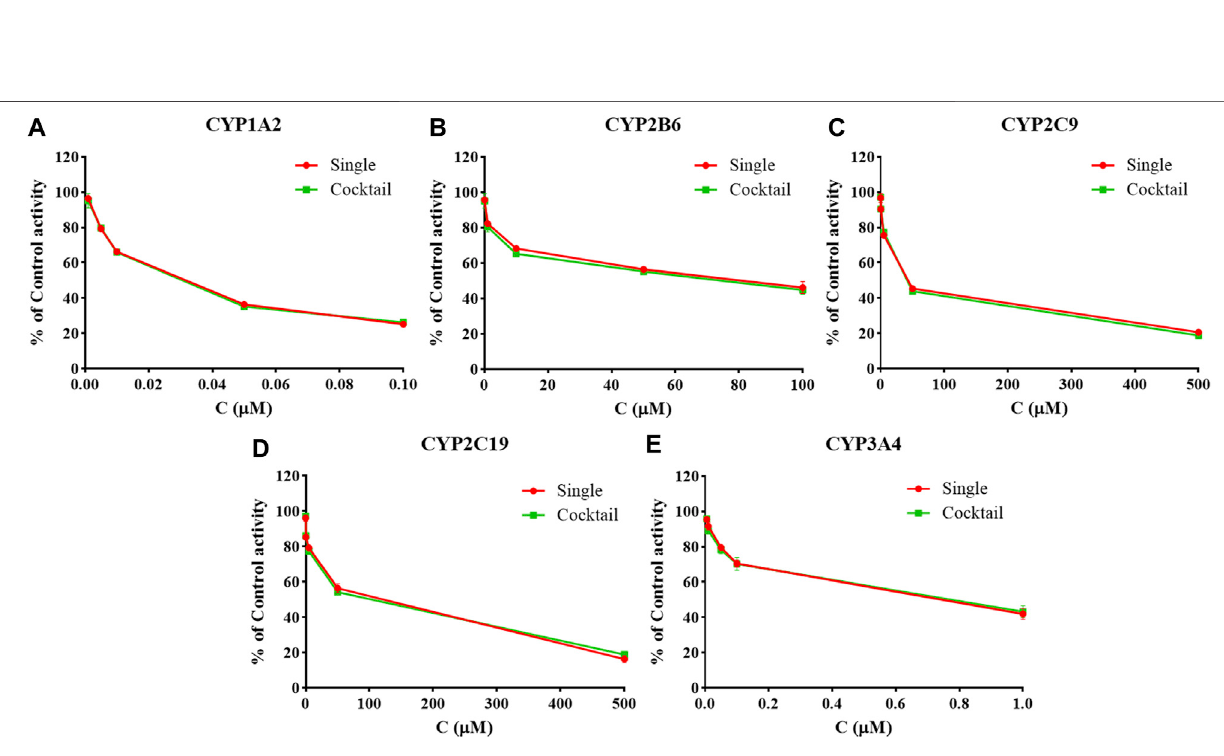
Frontiers in Pharmacology |